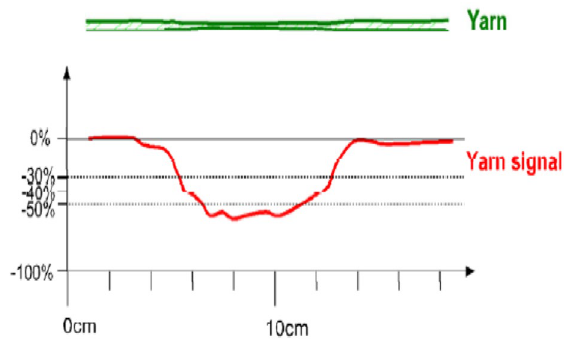
Figure 11. A thin place in a yarn and the corresponding yarn signal.